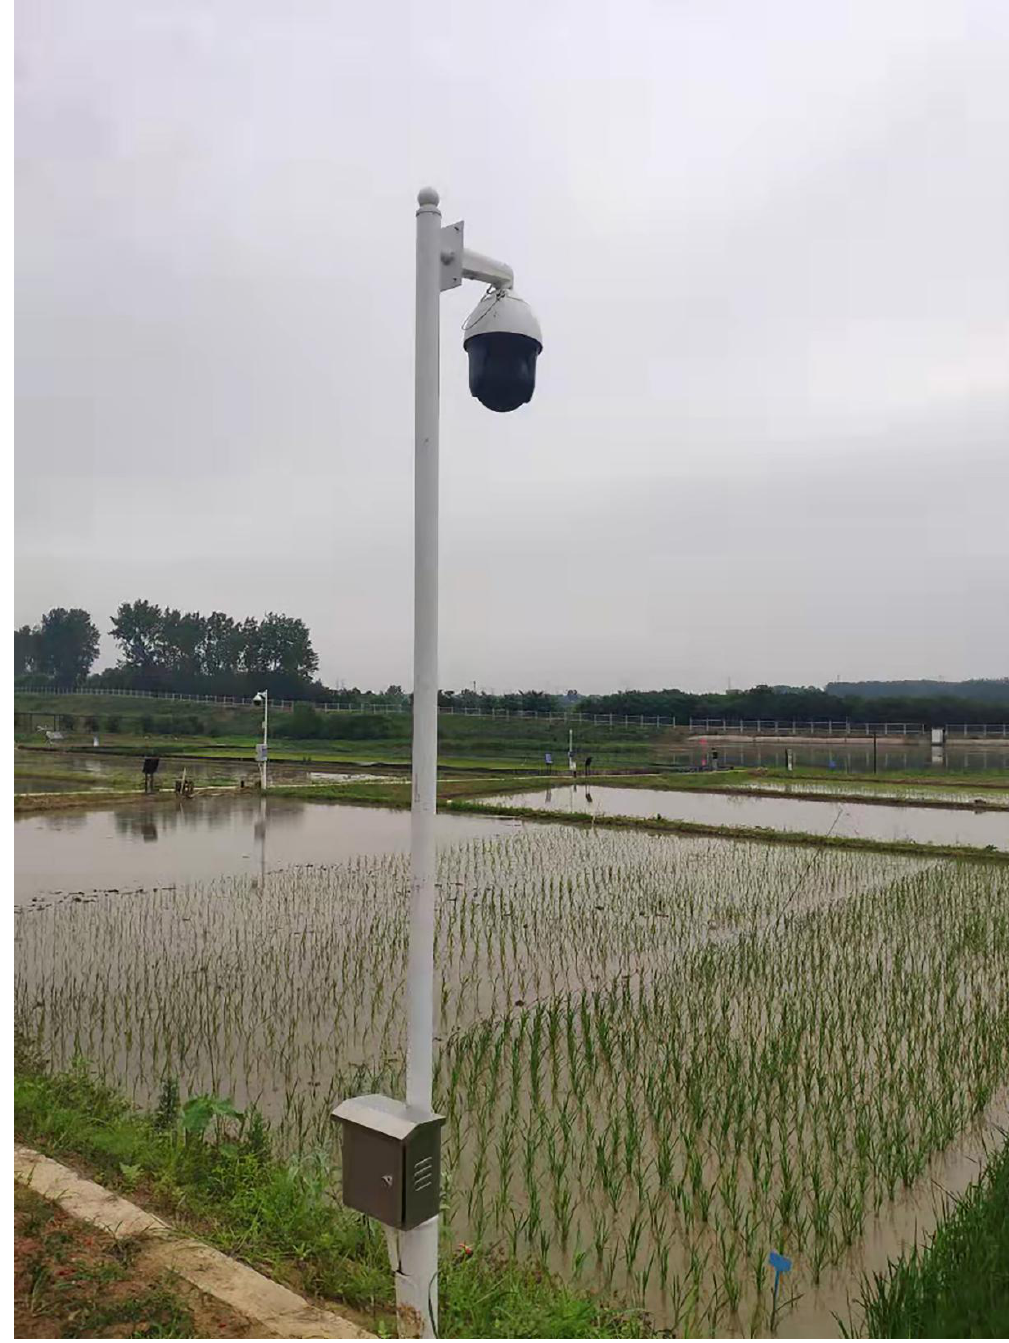
Figure A1. Capturing real-time images of a rice field with a web camera.